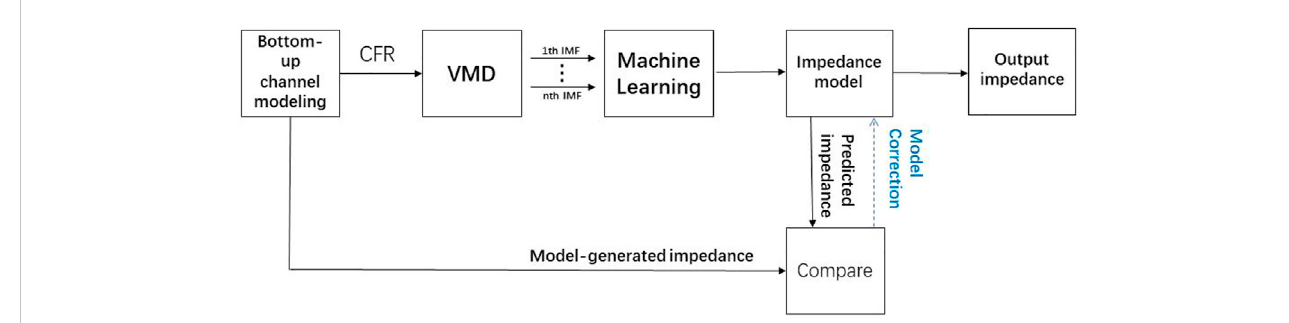
FIGURE 4 Flow chart of impedance estimation technique.